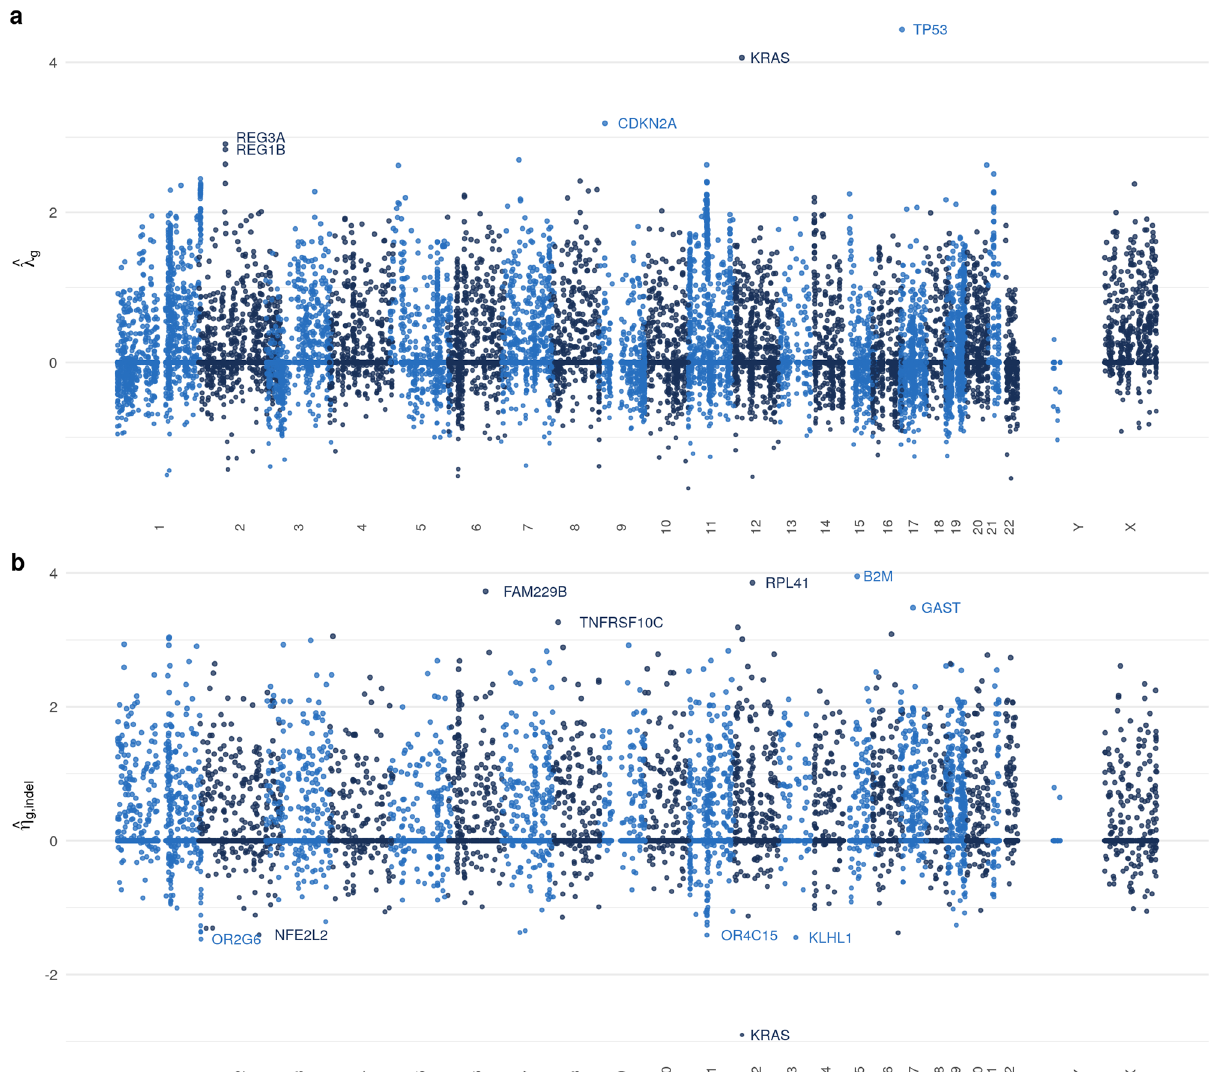
Fig. 2 Manhattan plots of generative model parameters. a Manhattan plot of fi tted parameters ^ λ g and their associated genes' chromosomal locations. The genes with the fi ve largest positive parameter estimates are labelled. b Manhattan plot of fi tted parameters ^ η chromosomal locations. The fi ve largest positive and negative genes are